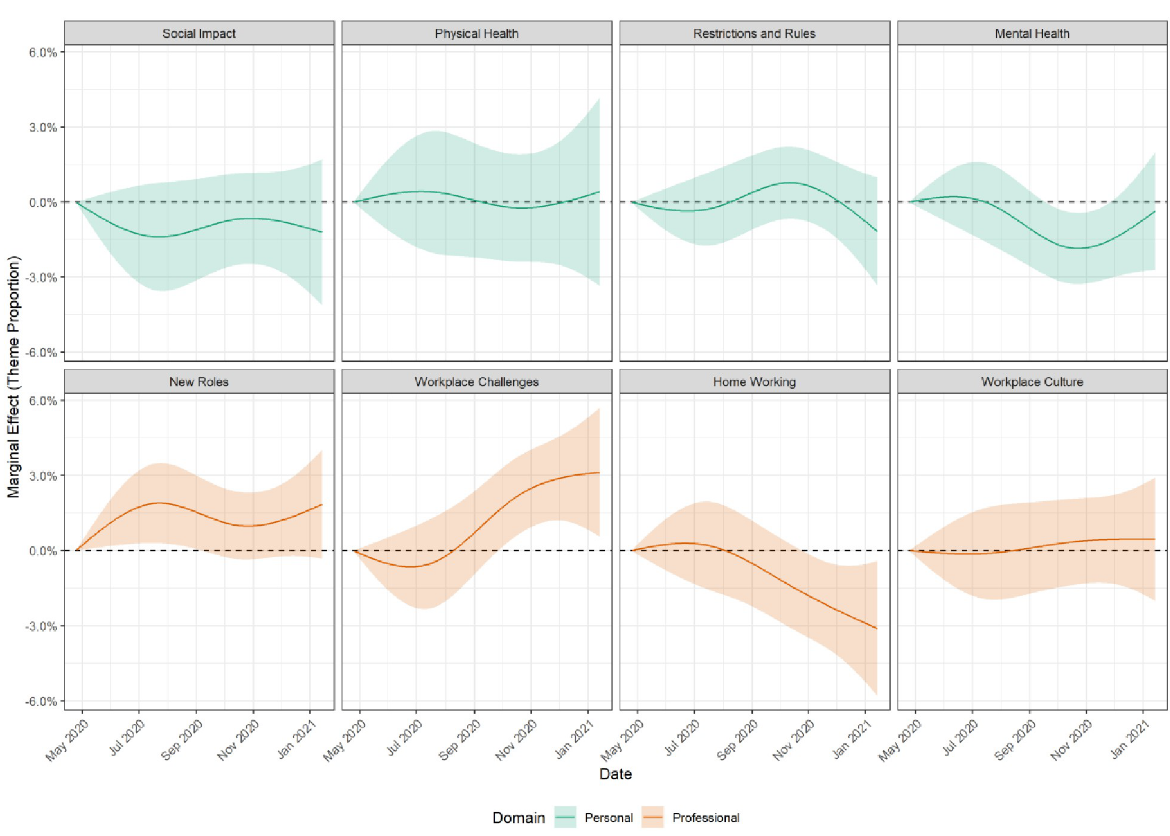
Fig 3. Marginal effect of date on estimated proportion of text devoted to theme. Derived from linear regression models including adjustment for age, date, sex, marital status, ethnicity and NHS trust. Source: Drawn by the authors from data analysed for this paper.